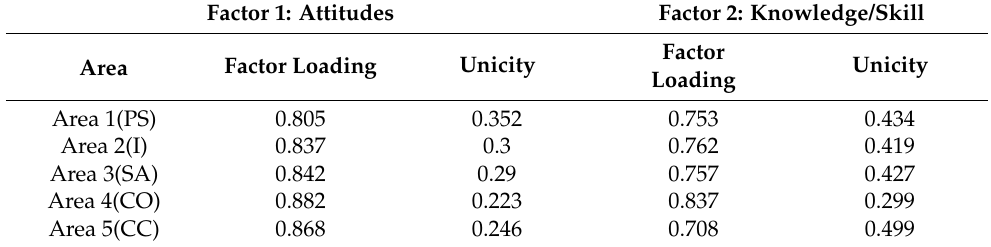
Table 6. Factor loadings.